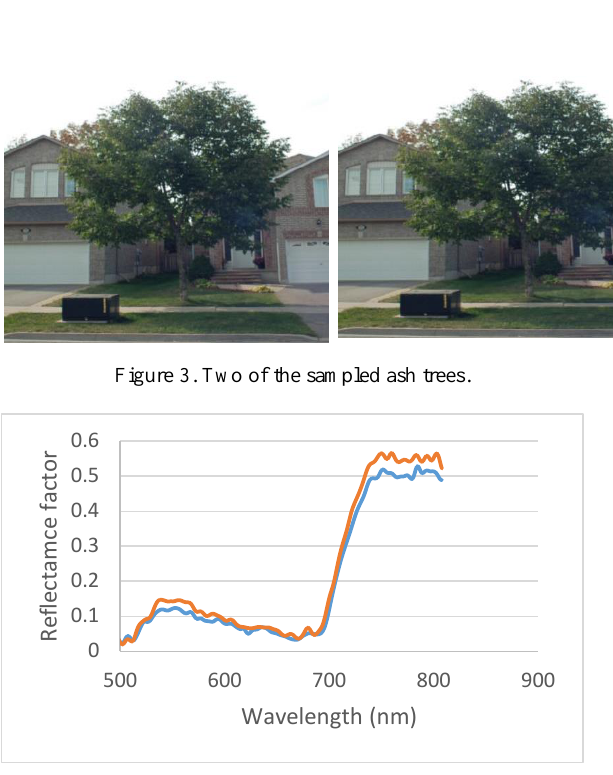
Figure 4. The reflectance spectrum of a healthy leaf (blue) and an unhealthy leaf